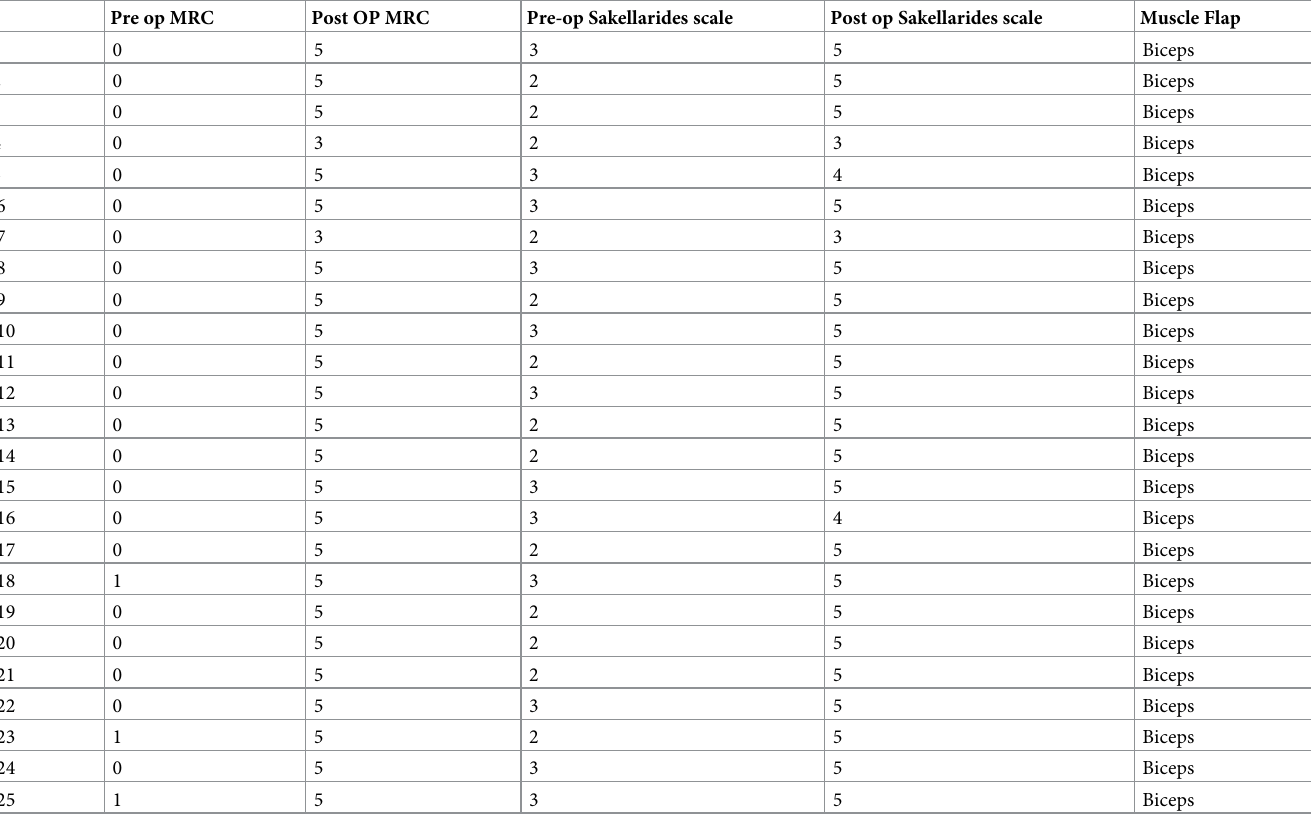
Table 1. Outcome of motor /sensory function after muscle flap